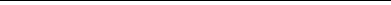
made of Minkowski embeddings. 2 In (cid:12)gure 4 we plot the electric current versus the electric (cid:12)eld for driving frequencies around the (cid:12)rs resonance. In (cid:12)gure 5 we represent the